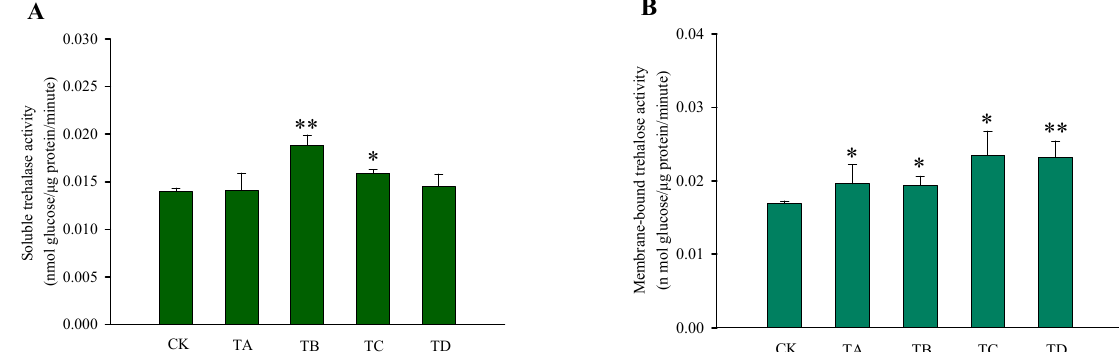
Figure 4. Changes in the trehalase activity of T. castaneum treated with different concentrations of high carbon dioxide represented CK, TA, TB, TC, and TD. ( A ) soluble trehalase activity; ( B ) mem ‐ brane ‐ bound trehalase activity. CK, treated with air for 48 h; TA, treated with 25% CO 2 + 75% air for 48 h; TB, treated with 50% CO 2 + 50% air for 48 h; TC, treated with 75% CO 2 + 25% air for 48 h; TD, treated with 95% CO 2 + 5% air for 48 h. * p < 0.05, ** p < 0.01, according to Student’s t ‐ test.